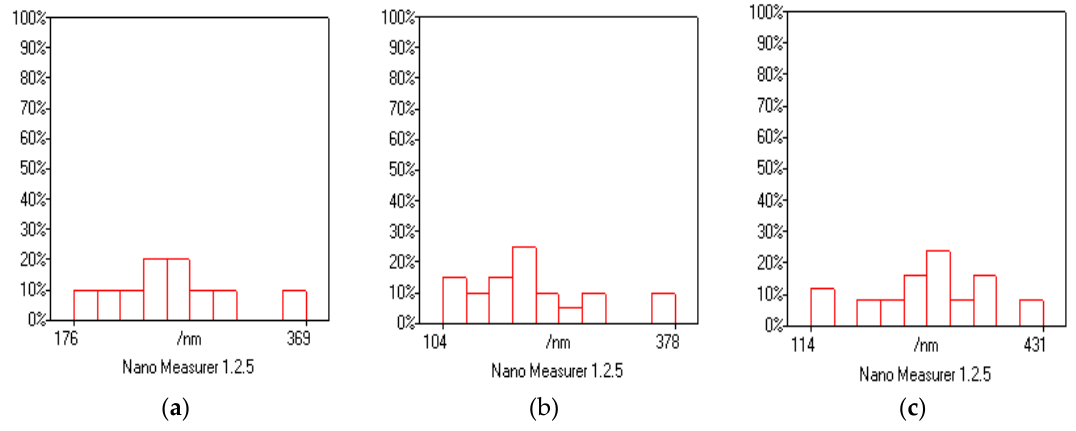
Figure 5. Nano Measure graphs showing particle size of ( a ) COP, ( b ) PPY, and ( c ) PTH.